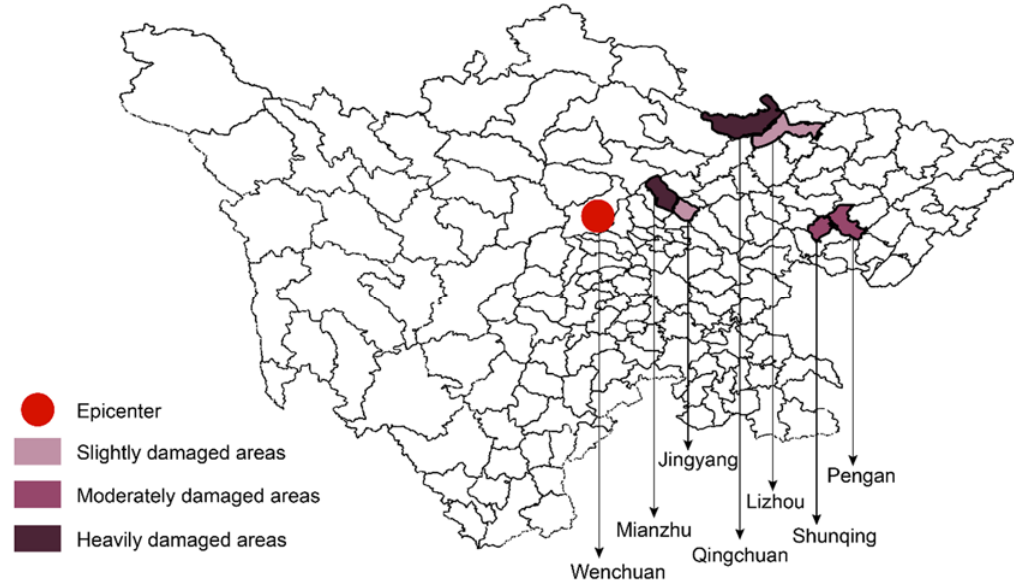
Figure 1. Map of survey regions.